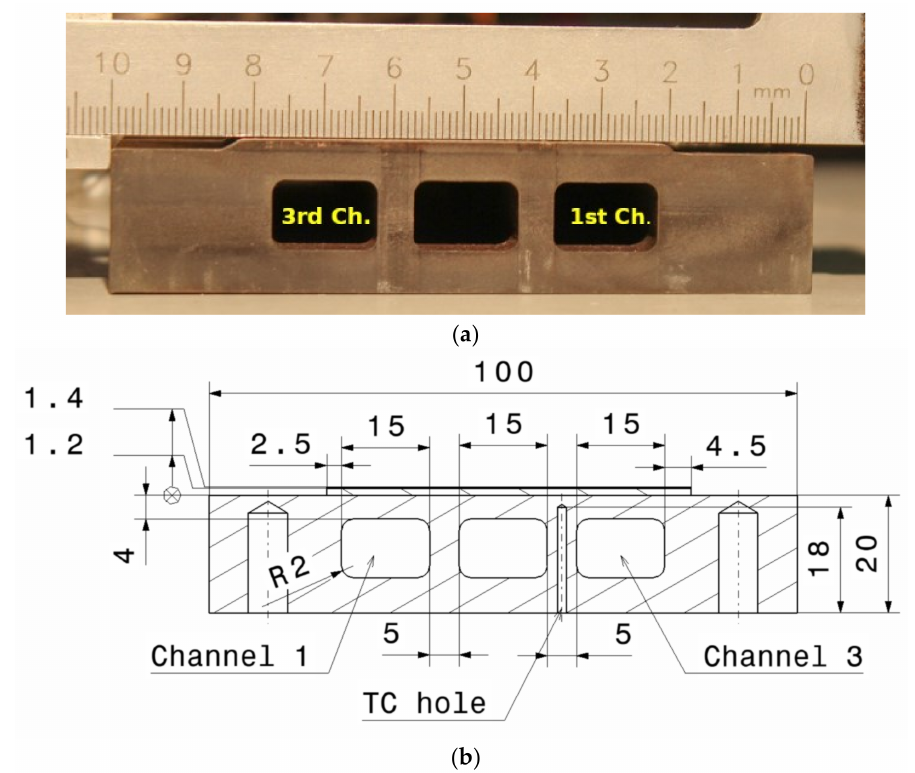
Figure 1. FG mock-up cross-section: ( a ) Picture of the mock-up cross-section as manufactured; ( b ) Drawing of the cross-section with dimensions including the final dimensions of the coating (1.2 mm FG layer +0.2 mm tungsten cover). Note that, during the final manufacturing steps, the mock-up lost about 0.6 mm from the initial 0.8 mm of the tungsten layer, as described in